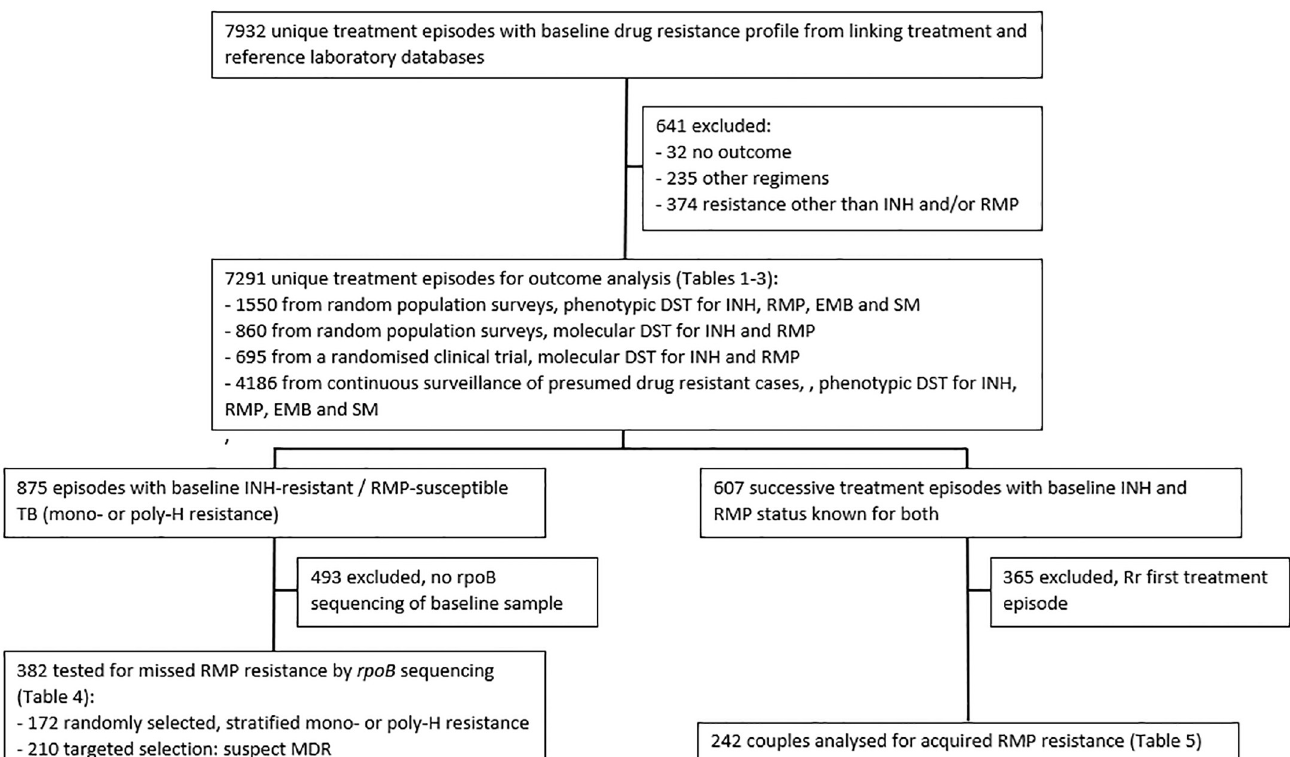
Fig 1. Flowchart showing the analysed populations. INH: isoniazid; RMP: rifampicin; EMB: ethambutol; SM: streptomycin; DST: drug susceptibility testing; TB: tuberculosis.